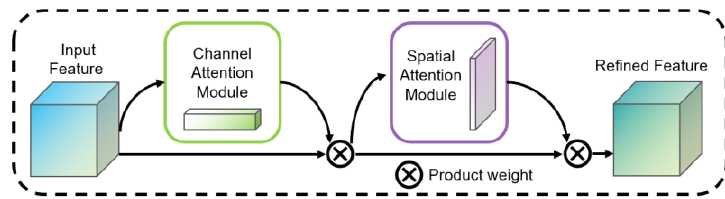
Figure 6. Module of